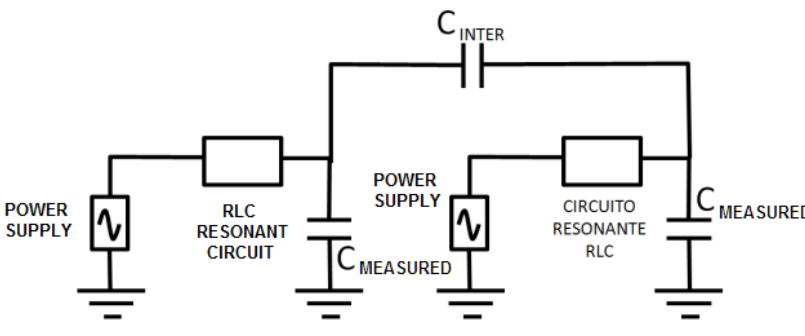
Figure 5. Scheme used in the simulation of interferences between sensor devices.